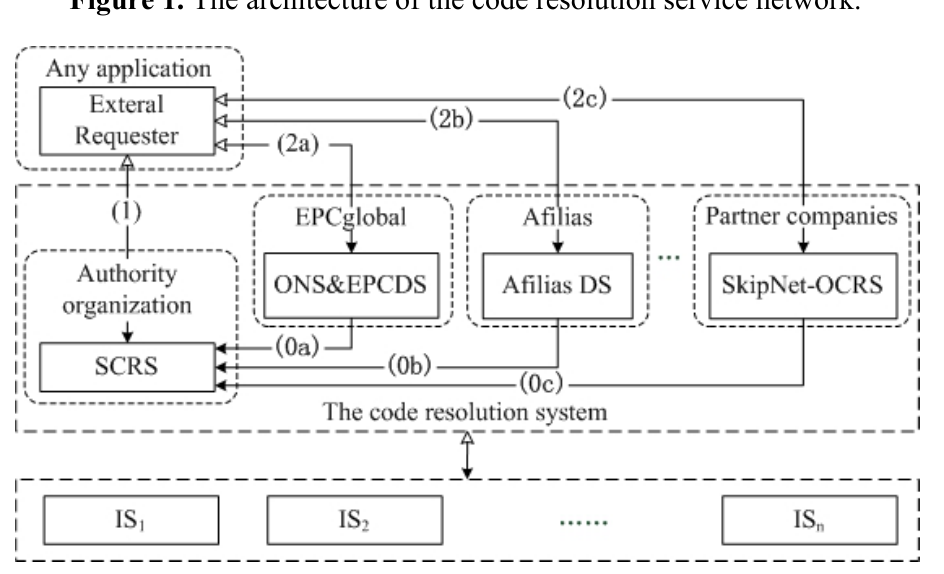
Figure 1. The architecture of the code resolution service